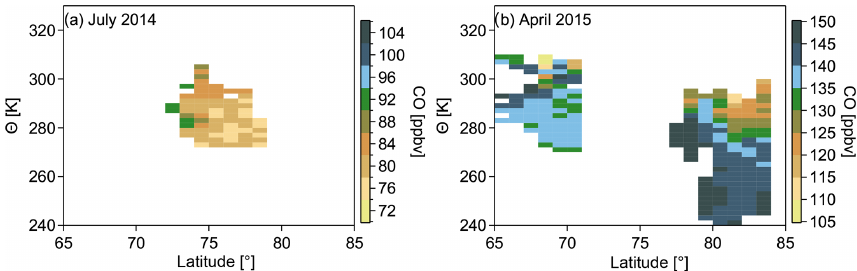
Figure 6. CO distribution binned by latitude and potential temperature for July 2014 (a) and April 2015 (b) . The color code represents the average CO mixing ratio calculated from all data points in the respective 1 ◦ latitude and 2K bin interval. Note that only background mixing ratios are shown now. Polluted air masses are identified and filtered when the average background distribution is exceeded by 2 σ .